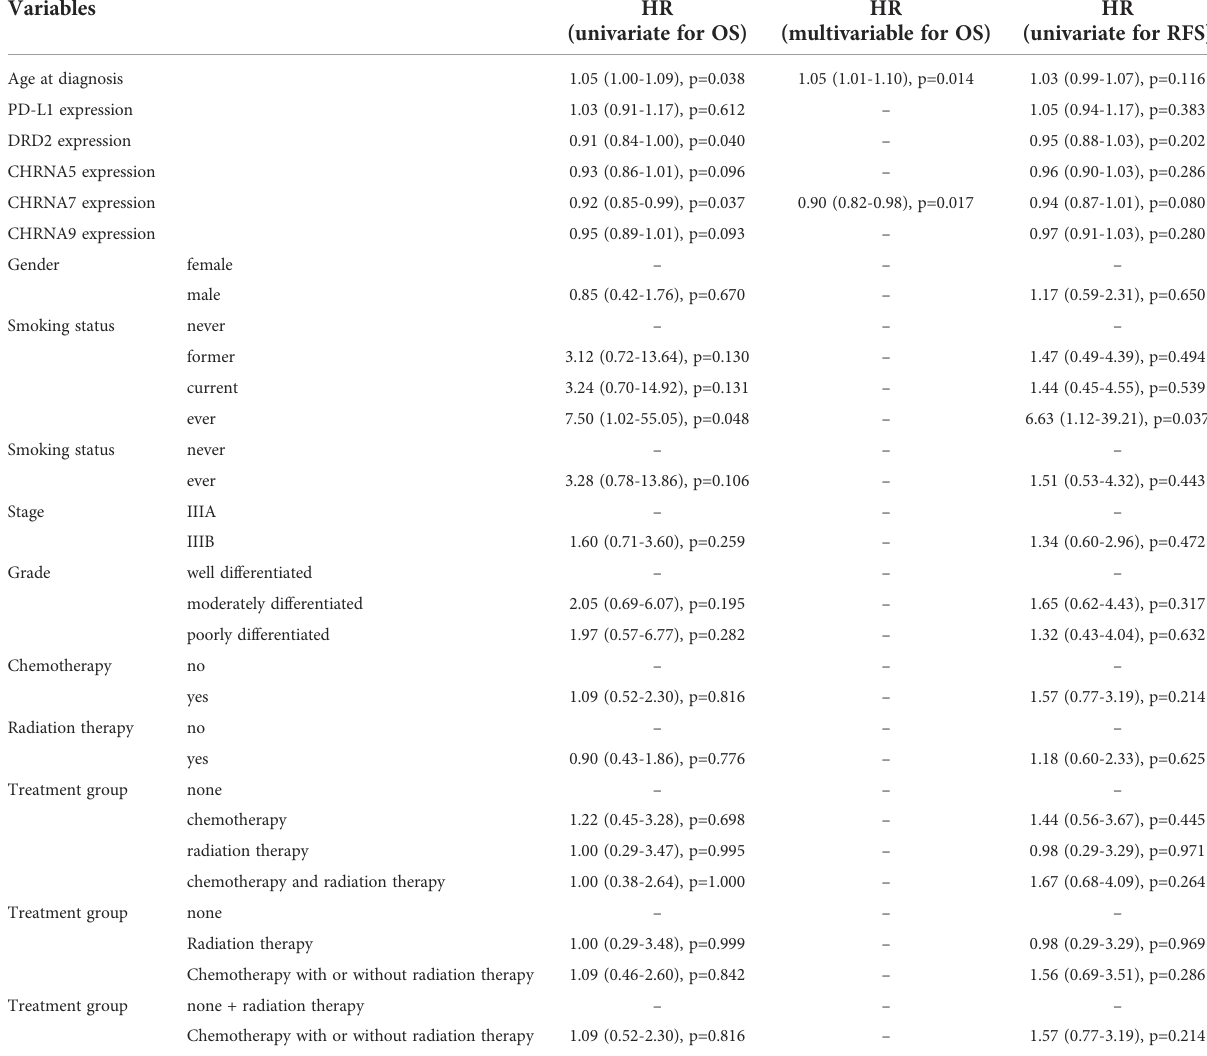
TABLE 3 Prognostic values of biomarkers, clinical factors, histopathological factors, and treatment in overall survival (OS) and relapse-free survival (RFS).